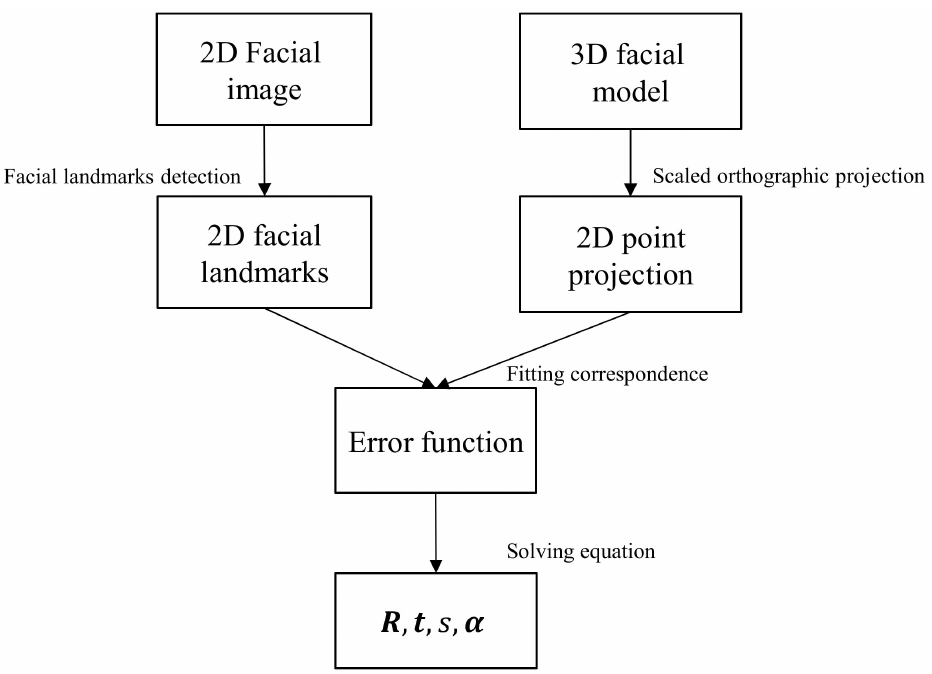
Figure 2. Pipeline to estimate the shape parameters of the 3DMM.